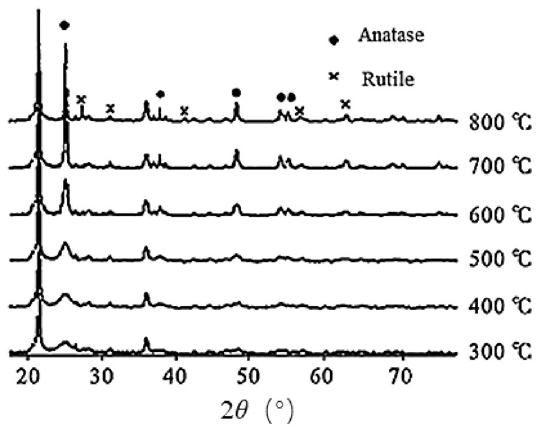
Figure 1. XRD patterns of DE-supported nano-TiO 2 prepared by precipitation method (TiOSO 4 , Urea) and calcined at 300–800 °C for 2 h 23 .